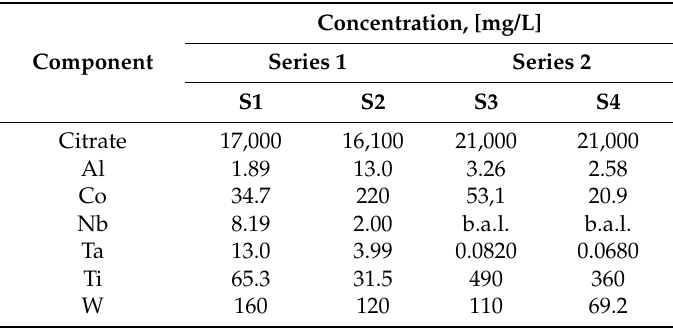
Table 1. Concentrations of the citrates and the different metal ions of the initial solutions S1, S2, S3, and S4 (b.a.l., below the analytical limit of determination) measured by IC and ICP-MS [3].